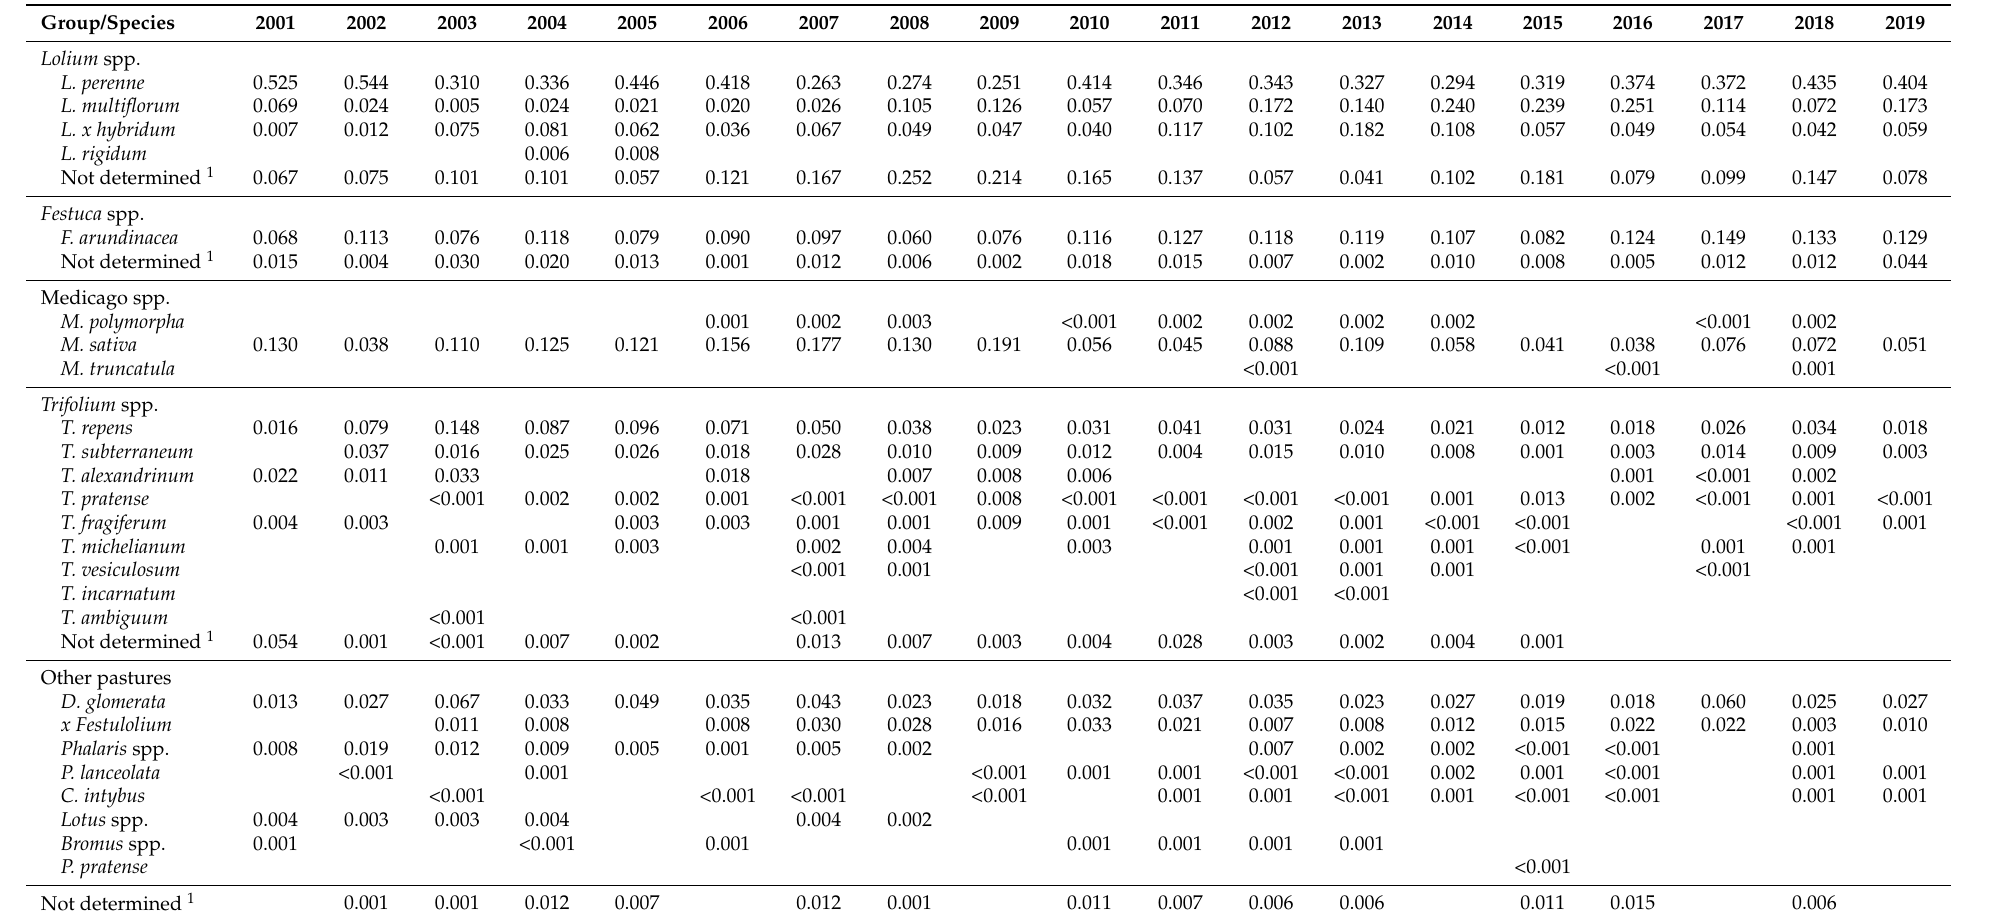
Table 3. Proportion of the total seed imports (PT) of species of pasture and related turfgrass by group from 2001 to